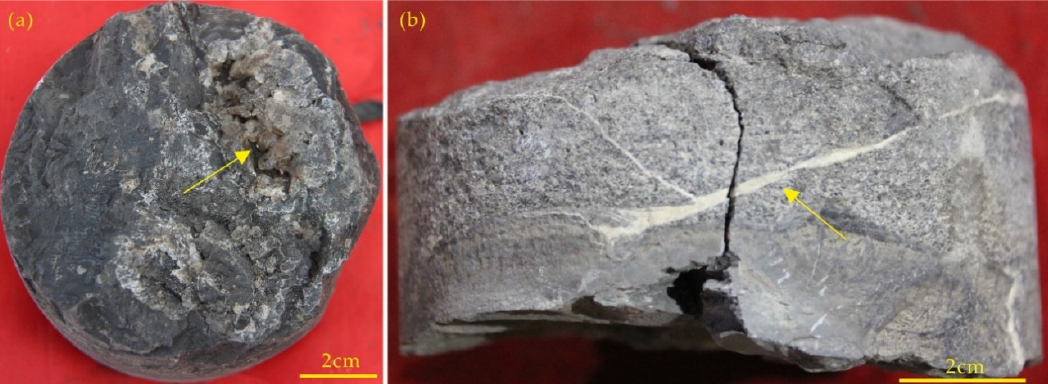
Figure 7. Images showing fractures with different fillings: ( a ) fracture half-filled with euhedral quartz; ( b ) fracture fully filled with calcite. The yellow arrows indicate the location of the fractures.